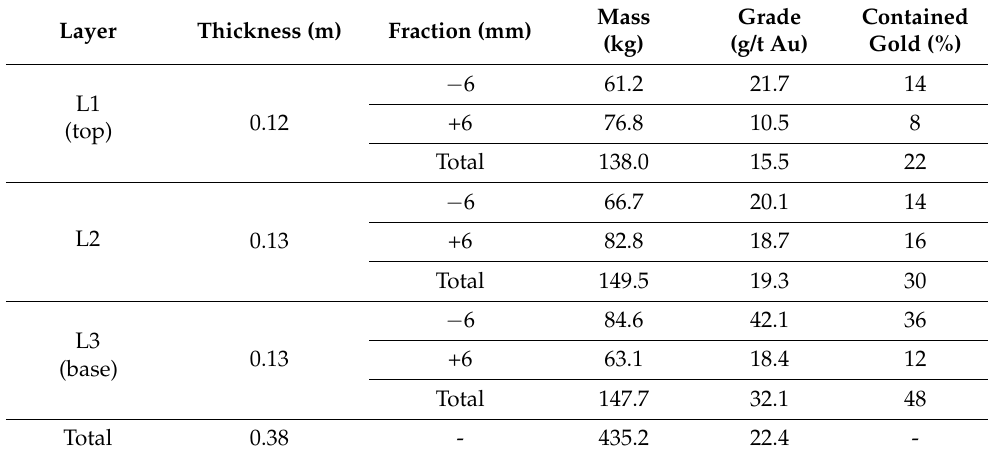
Table 9. Granulometric analysis (Sample SEG002) of three consecutive layers through the residue pile. Layer Thickness (m) Fraction (mm)